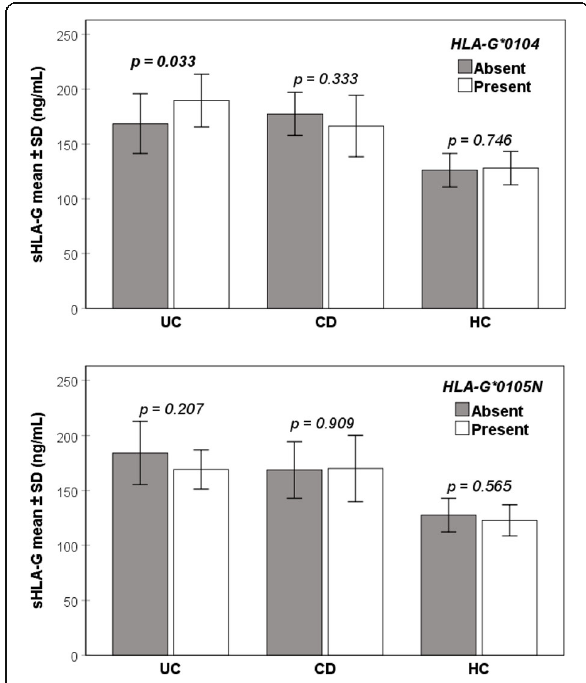
Fig. 2 Means of soluble HLA-G level distributed according to absence and presence of HLA-G*01:04 and HLA-G*01:05N allele in ulcerative colitis (UC) and Crohn ’ s disease (CD) patients and healthy controls (HC). p : Least significant difference probability (significant p value is indicated in